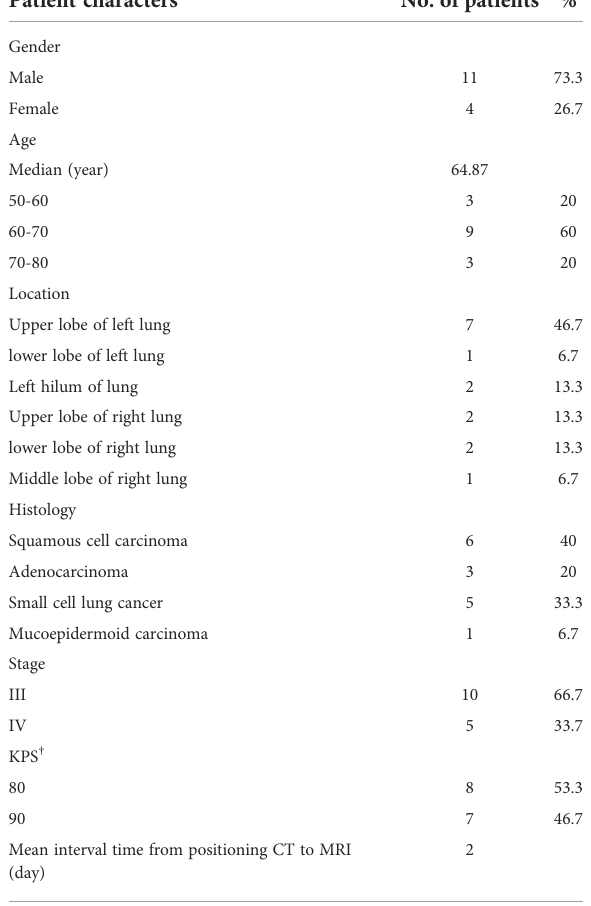
TABLE 1 Clinical characteristics of the 15 included